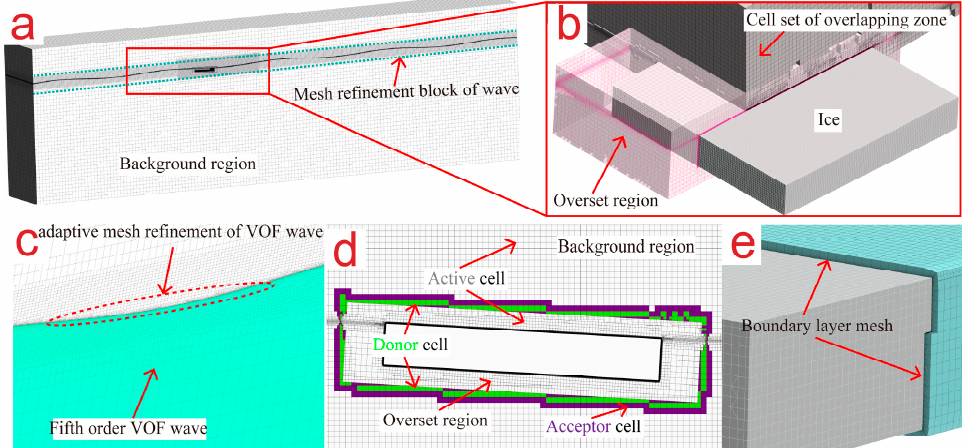
Figure 1. Computational mesh. ( a ) Overall of the mesh; ( b ) Mesh around the ice floe; ( c ) Adaptive mesh refinement of VOF wave; ( d ) Overset mesh; ( e ) Boundary layer mesh.